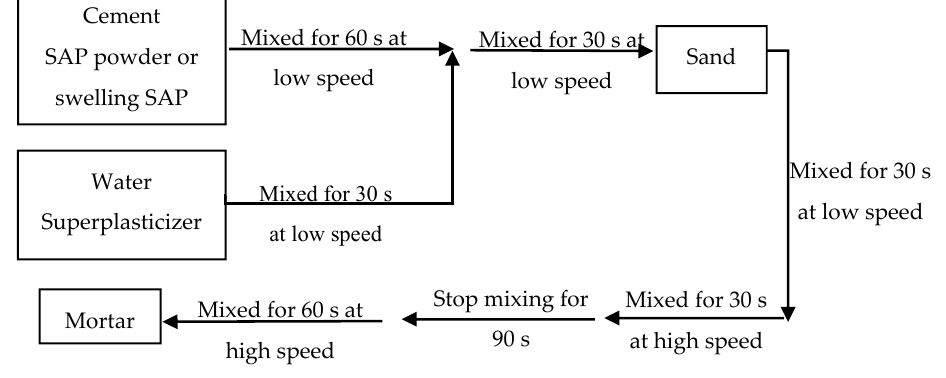
Figure 3. Mixing procedure of cement mortar with SAP.